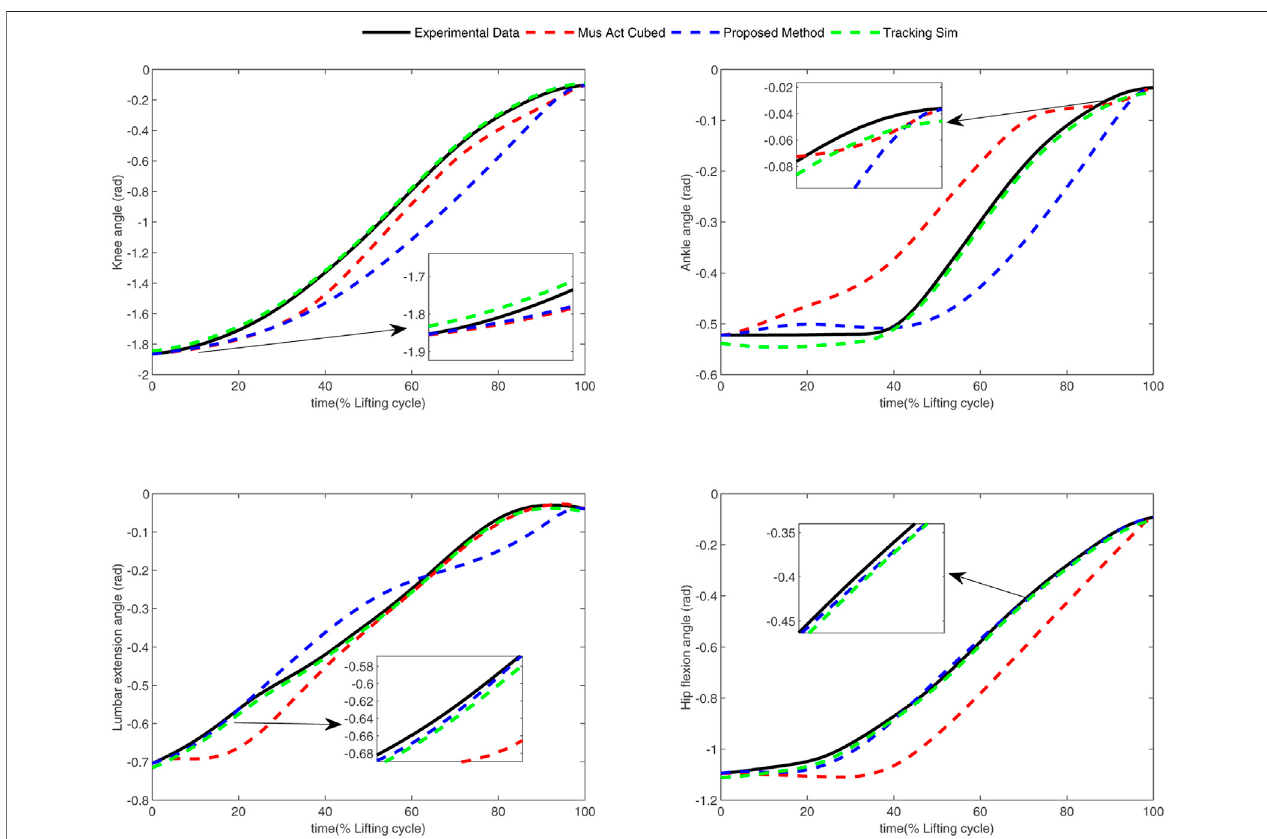
FIGURE 6 | Kinematics results of different joints obtained by different methods for subject 3.